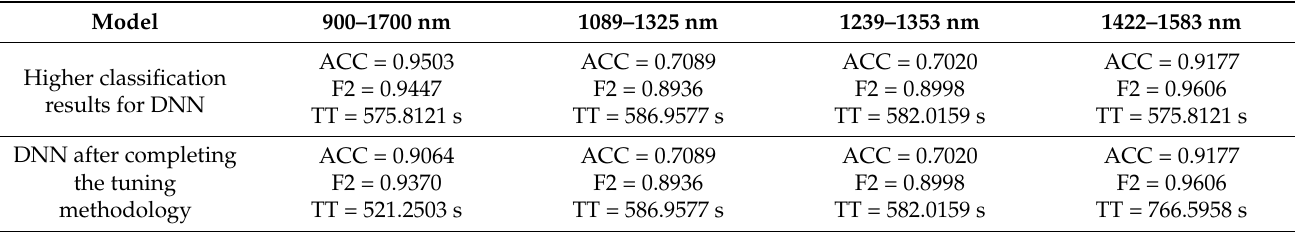
Table 8. Classification results for the DNN